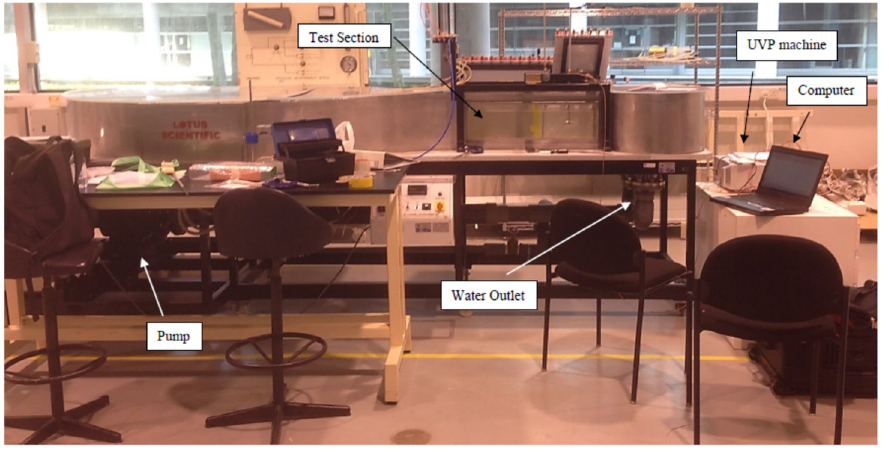
Figure 3. The water tunnel with the test section made of plexiglass for visualization purposes.